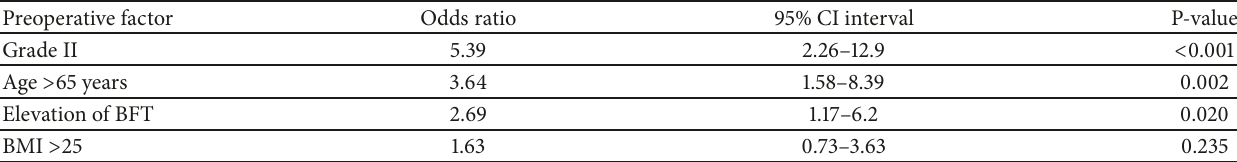
Table 3: Results of multivariate analysis for predictive